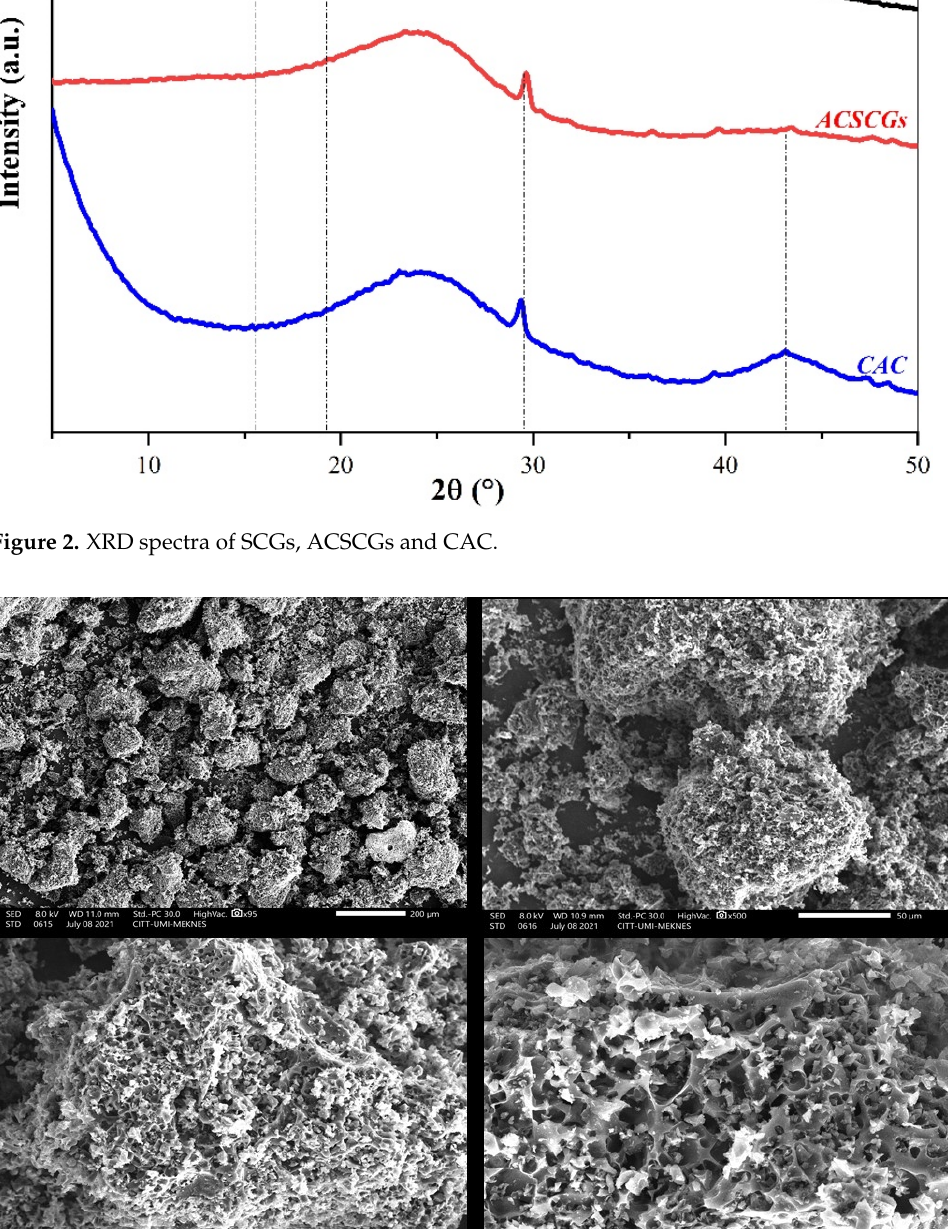
Figure 3. SEM micrographs of ACSCGs at different